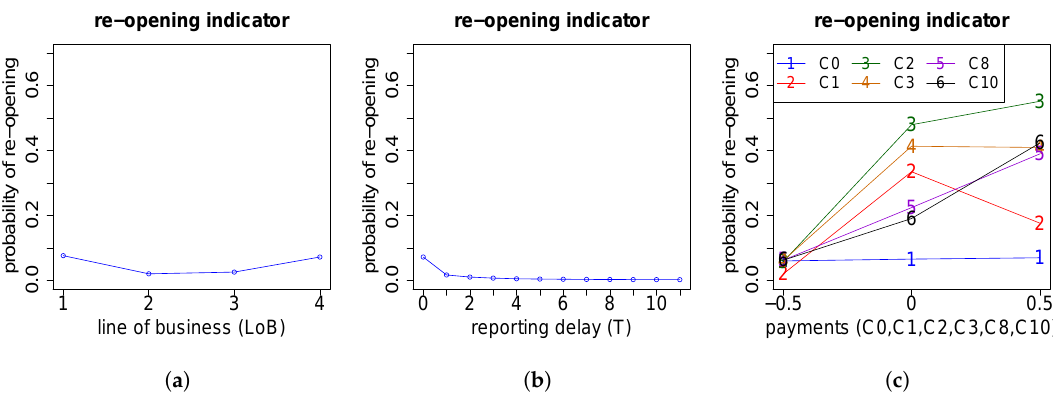
Figure A15. Re-opening indicator V w.r.t. the features ( a ) LoB ; ( b ) reporting delay T and ( c ) yearly payments C ( 0 ) , C ( 1 ) , C ( 2 ) , C ( 3 ) , C ( 8 ) , C ( 10 )